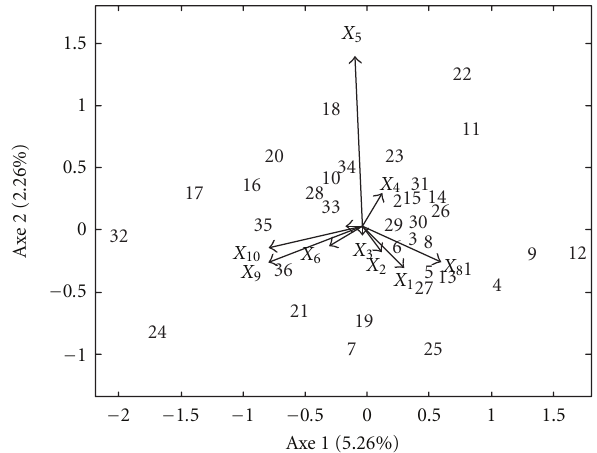
Figure 4: Joint plot conditioned on the second component the location mode for SREG